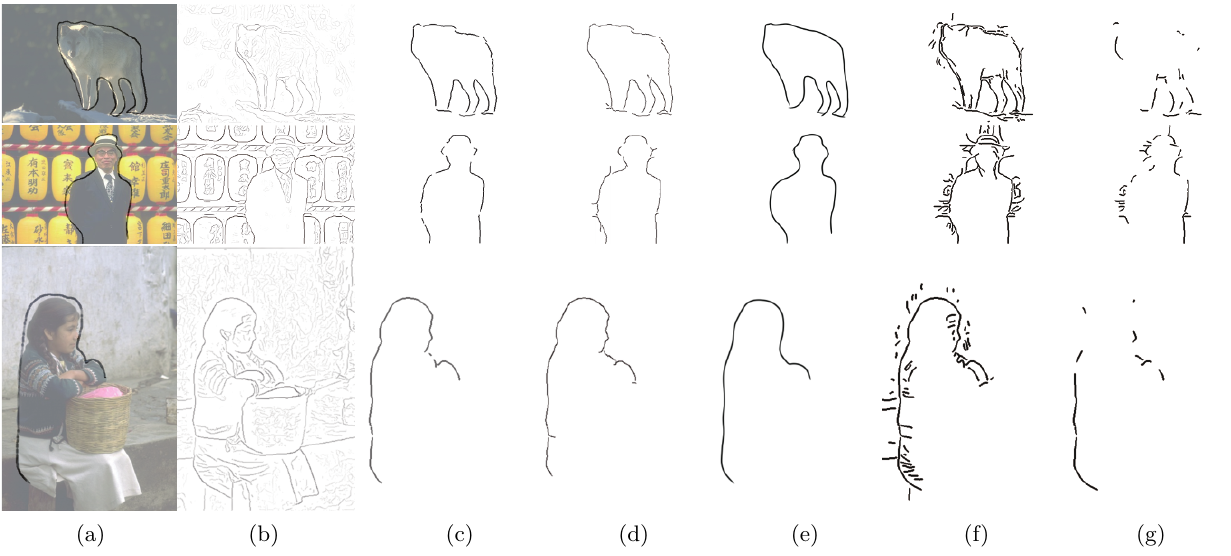
Fig. 10 Comparison with four other methods. (a) Input image and user strokes. (b) Ground truths corresponding to detailed line drawings by gPb [6]. (c)–(g) Lines extracted by (c) our system, (d) Yang et al. [16], (e) EZ-Sketching [8], (f) naive near neighbor search (NN), and (g) naive line-stroke intersection test